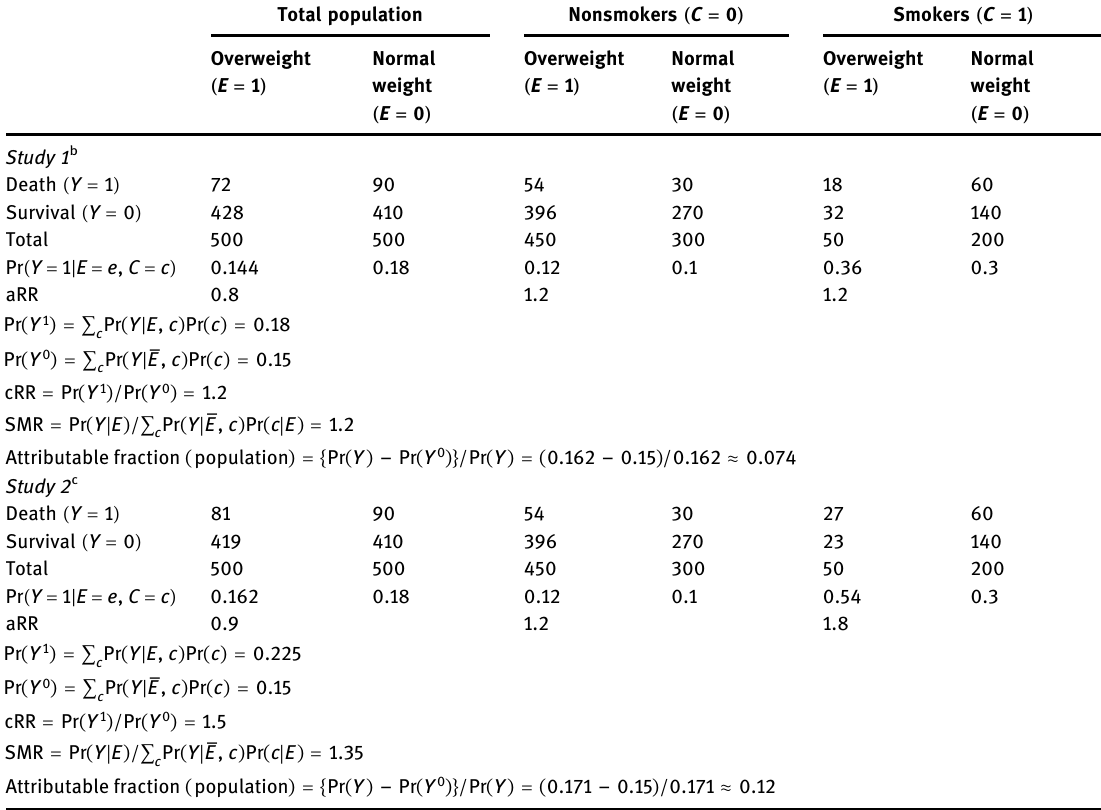
Table 2: Hypothetical examples of being overweight and mortality